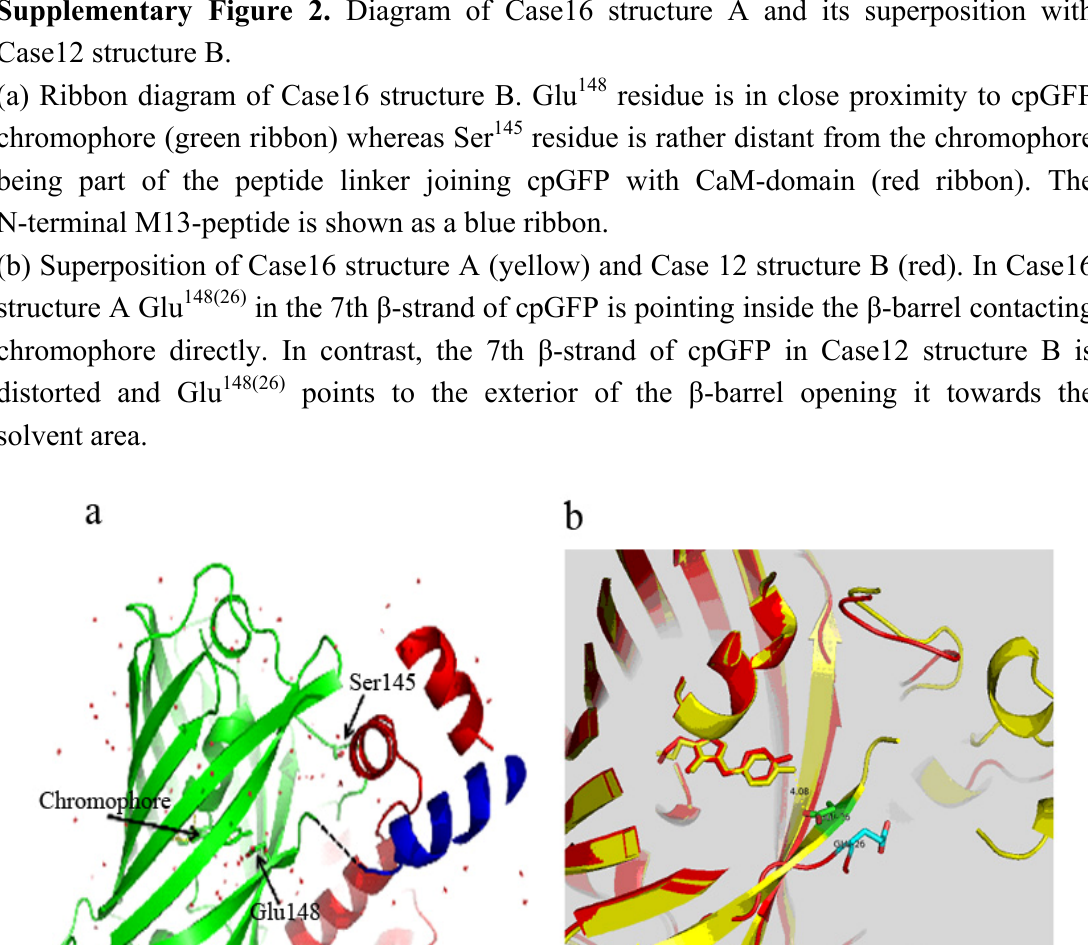
Supplementary Figure 2. Diagram of Case16 structure A and its superposition with Case12 structure